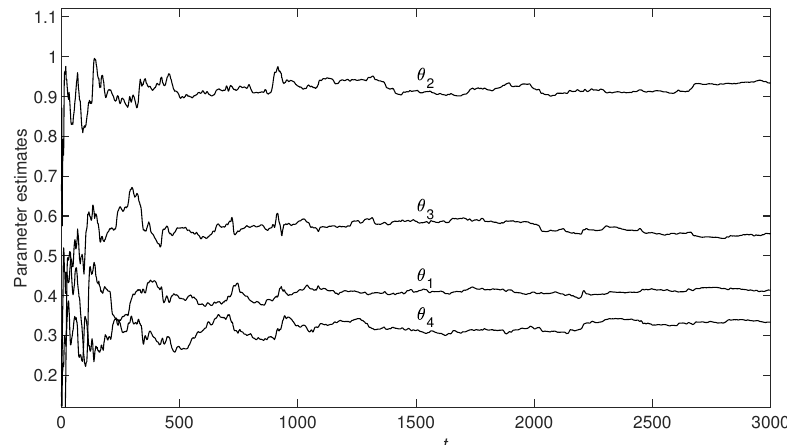
Figure 3. Parameter estimates ˆ θ 1 ( t ) , ˆ θ 2 ( t ) , ˆ θ 3 ( t ) , ˆ θ 4 ( t ) versus t .